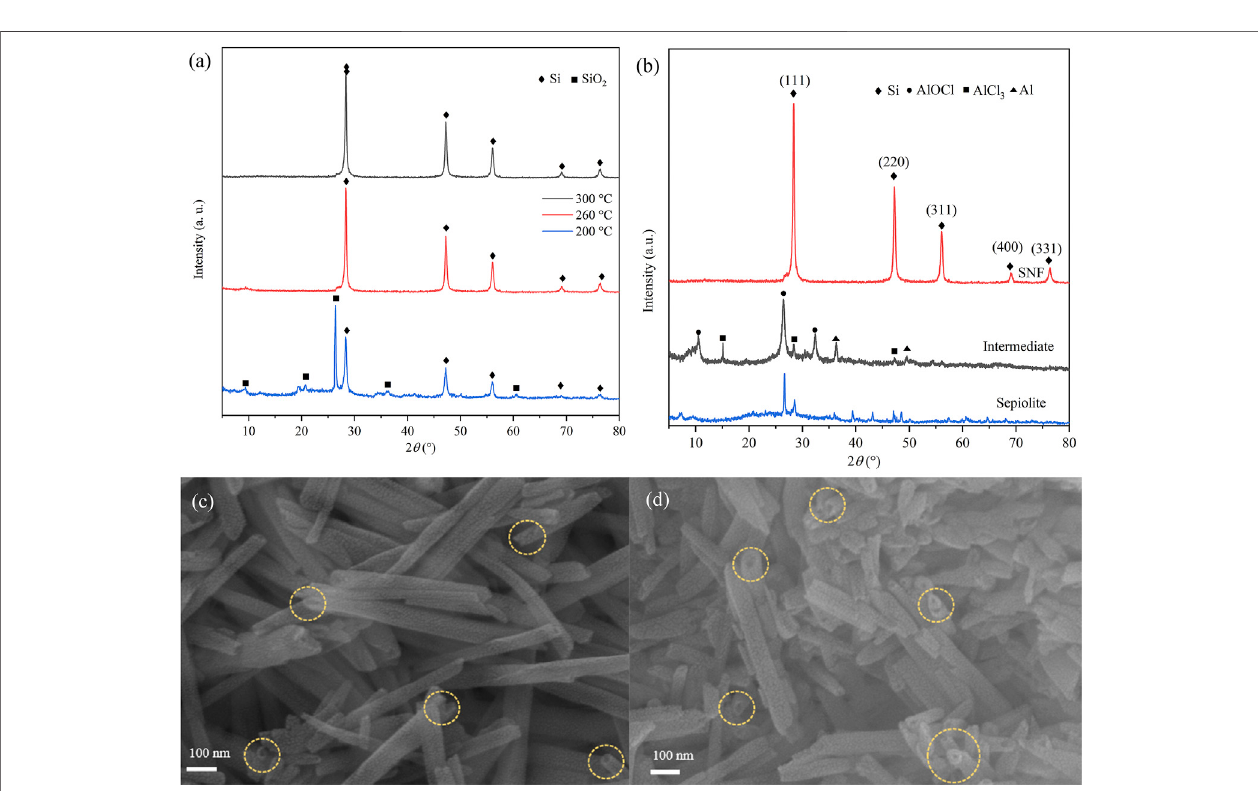
FIGURE 2 | XRD patterns of products in different (A) reaction temperatures and (B) reaction stages. SEM images of (C) natural sepiolite and (D) SNF showing 1D nano fi ber morphology (Yellow ring marks material pores).